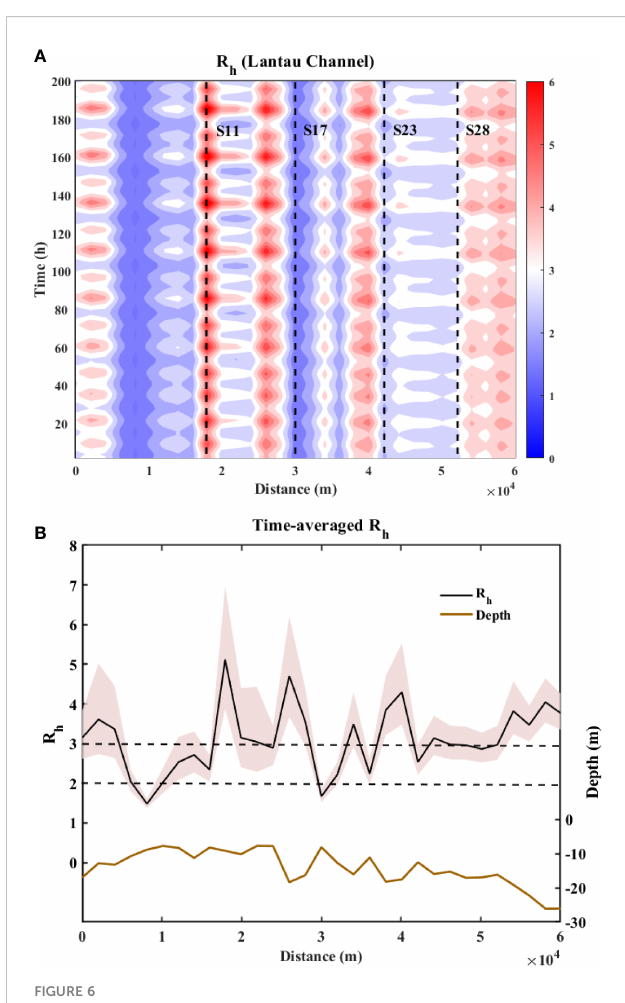
FIGURE 6 (A) Temporal and spatial variations of R h , i.e., ratio of main channel depth to averaged fl oodplain depth. Contour presenting the shift of R h with the tidal cycles in the Lantau Channel. Distance equaling zero represents the north end of the Lantau Channel. The counting of distance followed the thalweg of the Lantau Channel (section S1) and ended at the south end of the Pearl River Estuary (PRE). The relative location of S11, S17, S23, and S28 are indicated in dash lines. (B) The dashed line shows time-averaged variations of R h along the Lantau Channel. The solid line shows the bathymetry of the Lantau Channel from the north to the south end. The red area represents the area between the maximum and minimum R h calculated by main channel depth divided by averaged fl oodplain